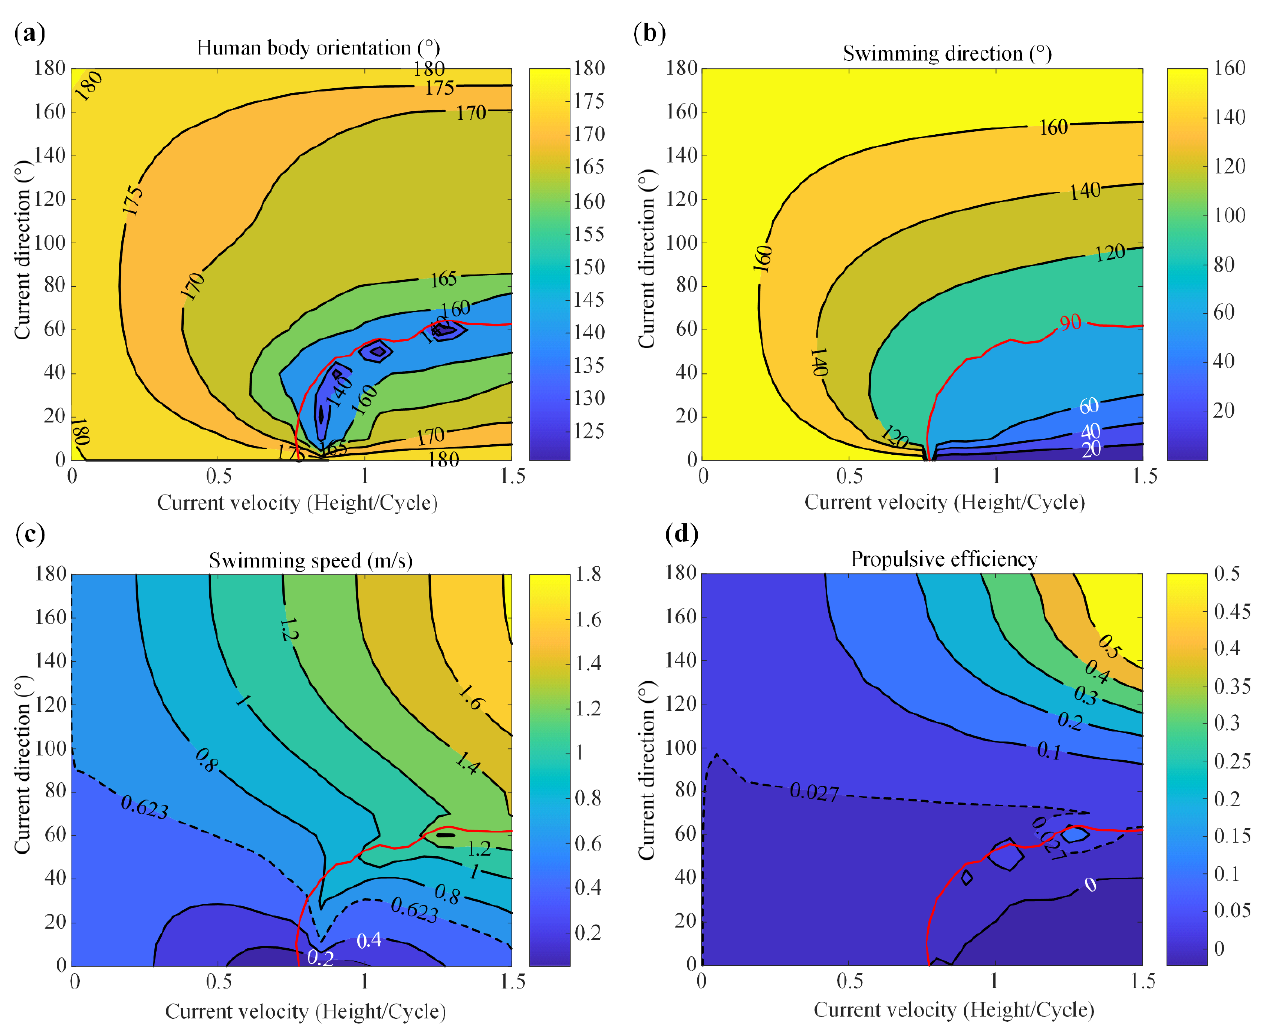
Figure 9. Parametric analysis results of the effects of currents on breaststroke swimming performance. Contour plots of ( a ) human body orientation, ( b ) swimming direction, ( c ) swimming direction, and ( d ) propulsive efficiency are provided. The red curve denotes the current conditions under which the human swims along the y direction. The dashed curve in ( c ) denotes the swimming speed in still water, and the dashed curve in ( d ) denotes the propulsive efficiency in still